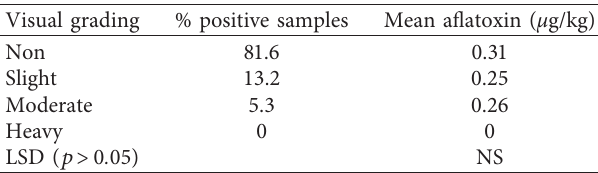
Table 6: Relationship between aflatoxin levels and degree of